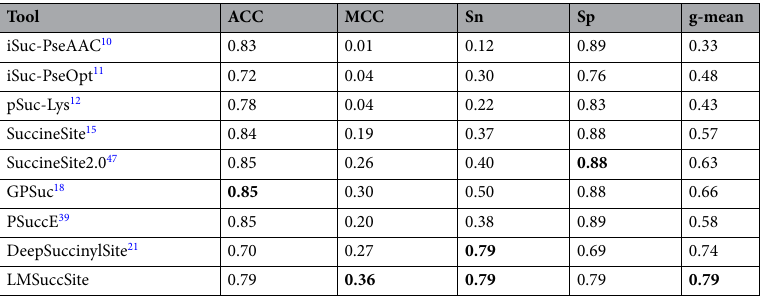
Table 4. Comparison of our model with existing succinylation prediction tools using an independent test set. The numbers are rounded to two significant digits after the decimal. The highest value in each category is shown in bold. ACC Accuracy, MCC Matthew’s Correlation Coefficient, Sn Sensitivity, Sp Specificity, g‑mean geometric mean.